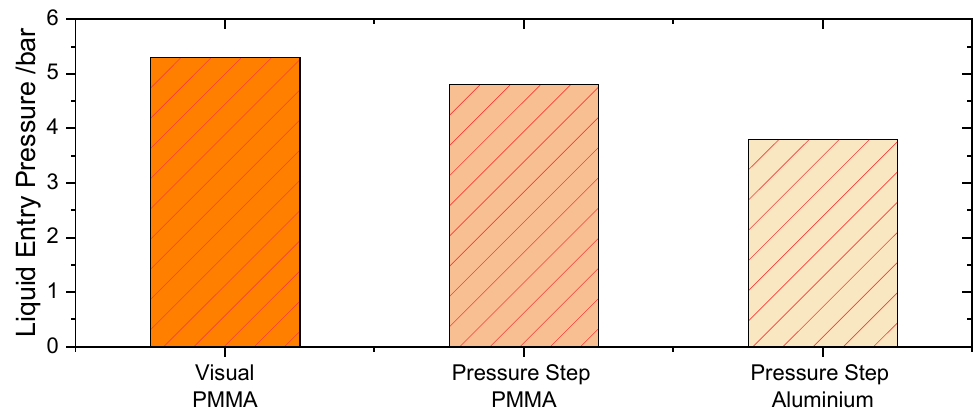
Figure 8. LEP values for the PTFE (PET) 100 nm membrane using the Visual Method and the Pressure Step Method in the PMMA cell as well as the Pressure Step Method results in the aluminum test cell.